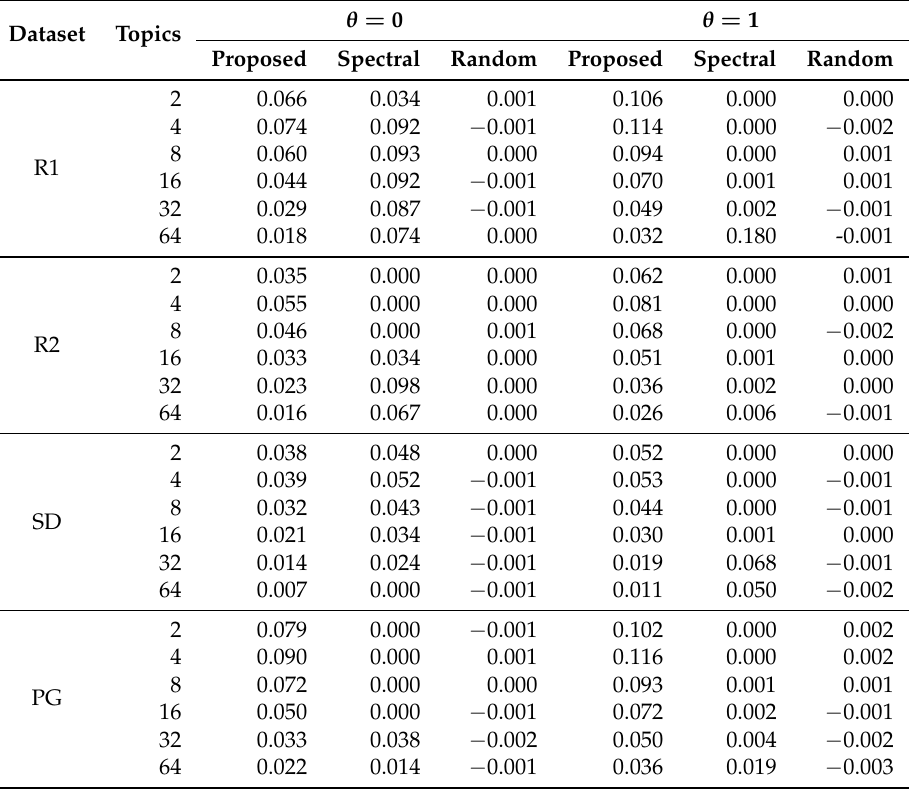
Table 6. Clustering performance in terms of